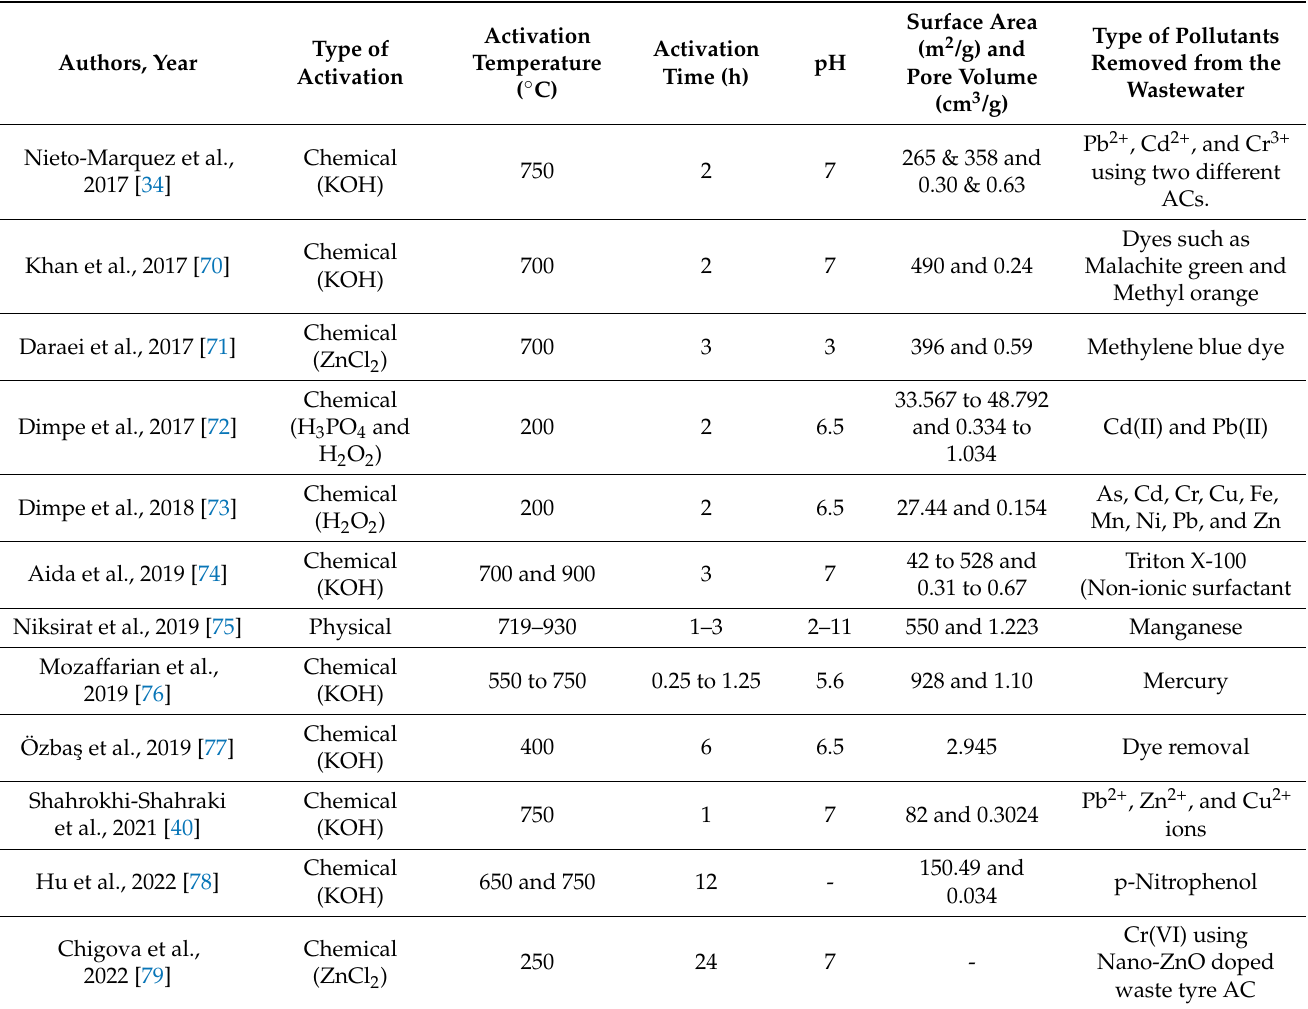
Table 2. An overview of recent studies on the production of waste tyre-derived activated carbon for wastewater